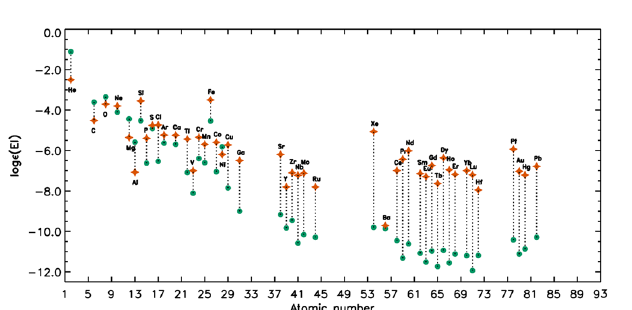
Figure 3. Comparison of the chemical composition of HD 66051 (orange stars) to the solar abundance pattern (green circles). The elements overabundant in HD 66051 are indicated above the symbol, whereas the underabundant elements are indicated